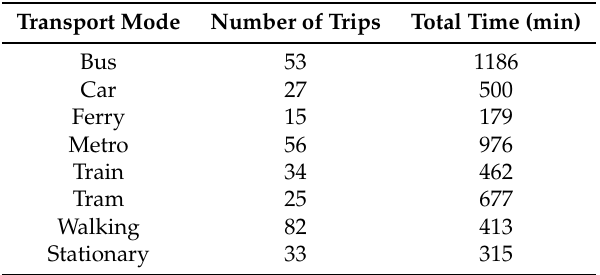
Table 1. Transport mode